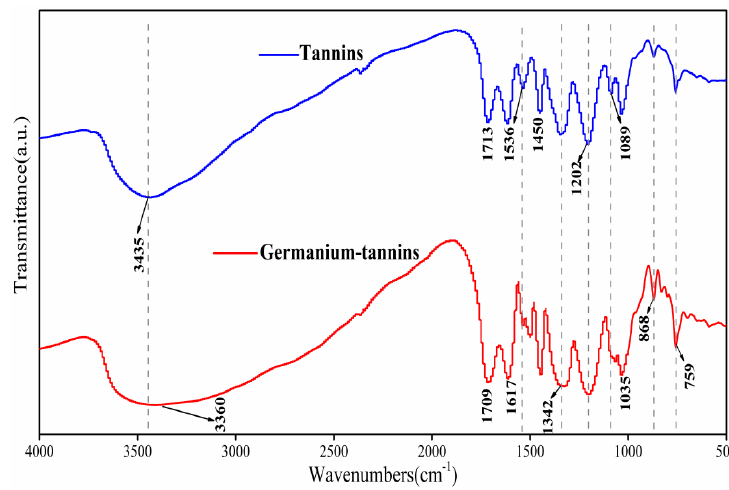
Figure 3. FT − IR spectra of tannins and germanium–tannins. Figure 3. FT-IR spectra of tannins and